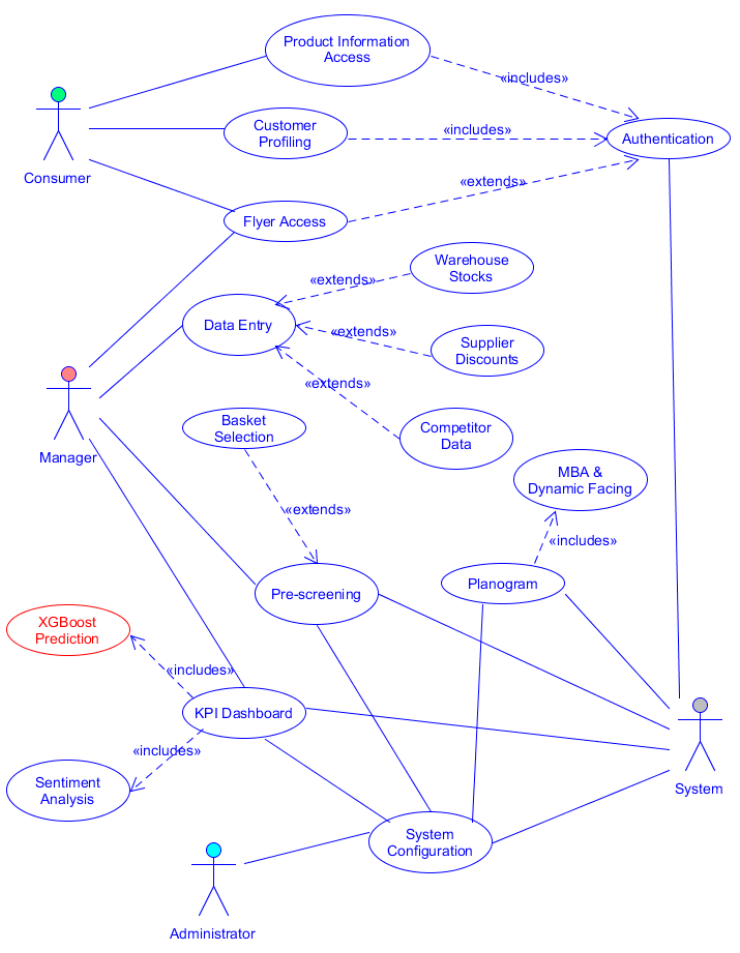
Figure 1. UML UCD of the implemented system. The paper discusses the implementation and results of the XGBoost algorithms used for sales prediction.